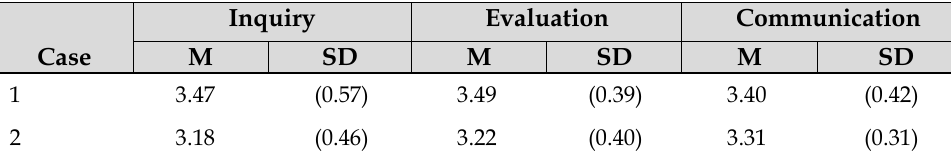
Table 4 Mean and standard deviation, Temple HSL rubric assessment, three raters